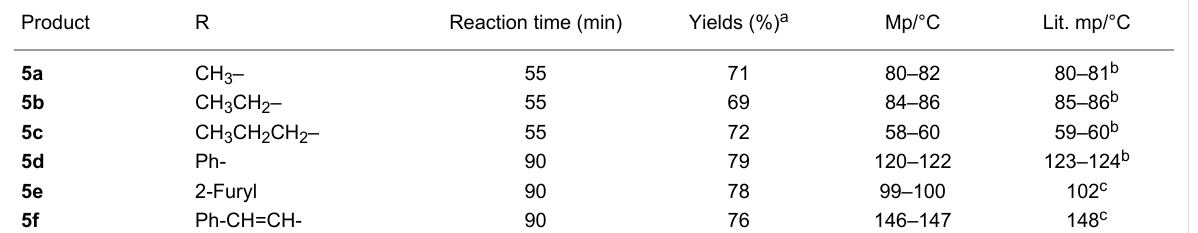
Table 1: Results of reaction between 2a – f and